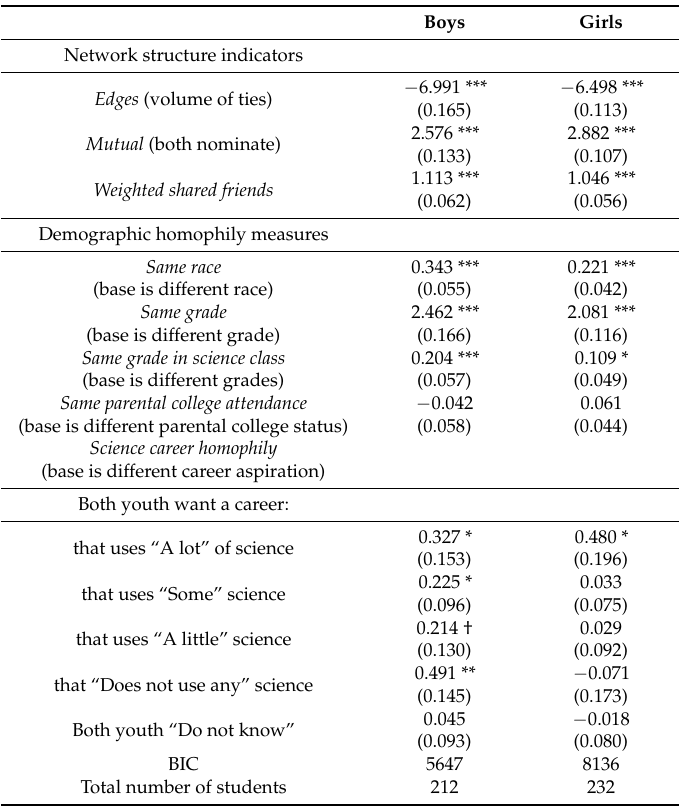
Table 5. Exponential random graph model of friendship ties (outcome) by network structure indicators, demographic homophily measures, and science career homophily separately by gender. Boys Girls Network structure